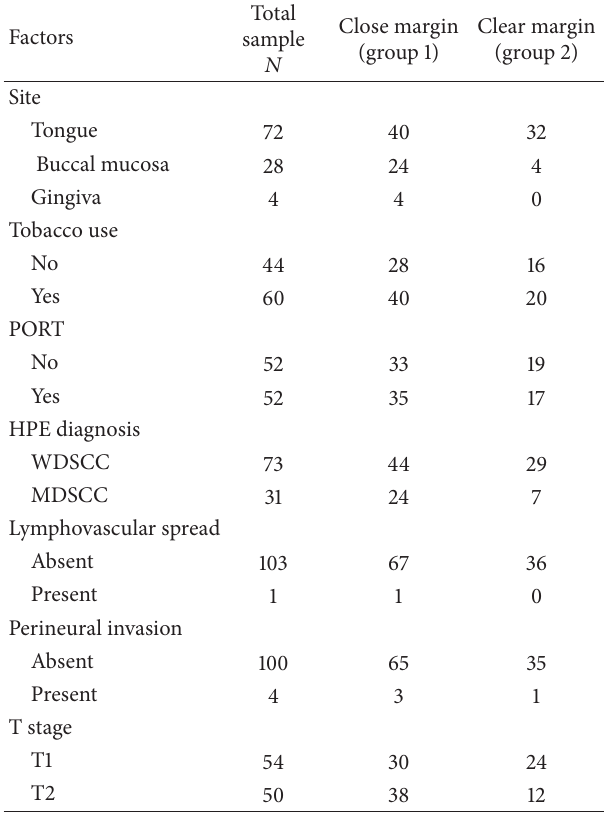
Table 1: Demographic, prognostic factors of the